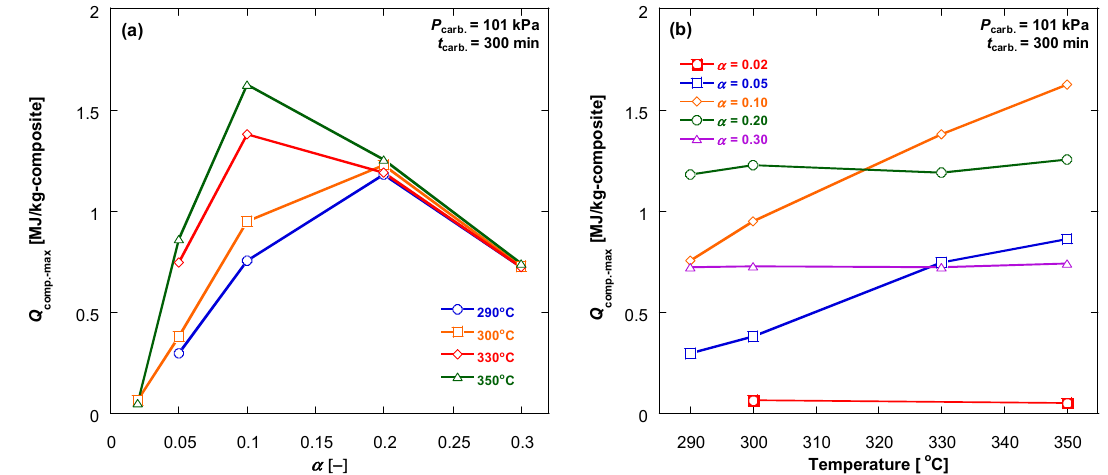
Figure 9. Changes of maximum specific useful heat, Q comp.-max : (a) Q comp.-max by salt content in the composite, α , and (b) Q comp.-max by carbonation temperature, T carb. .